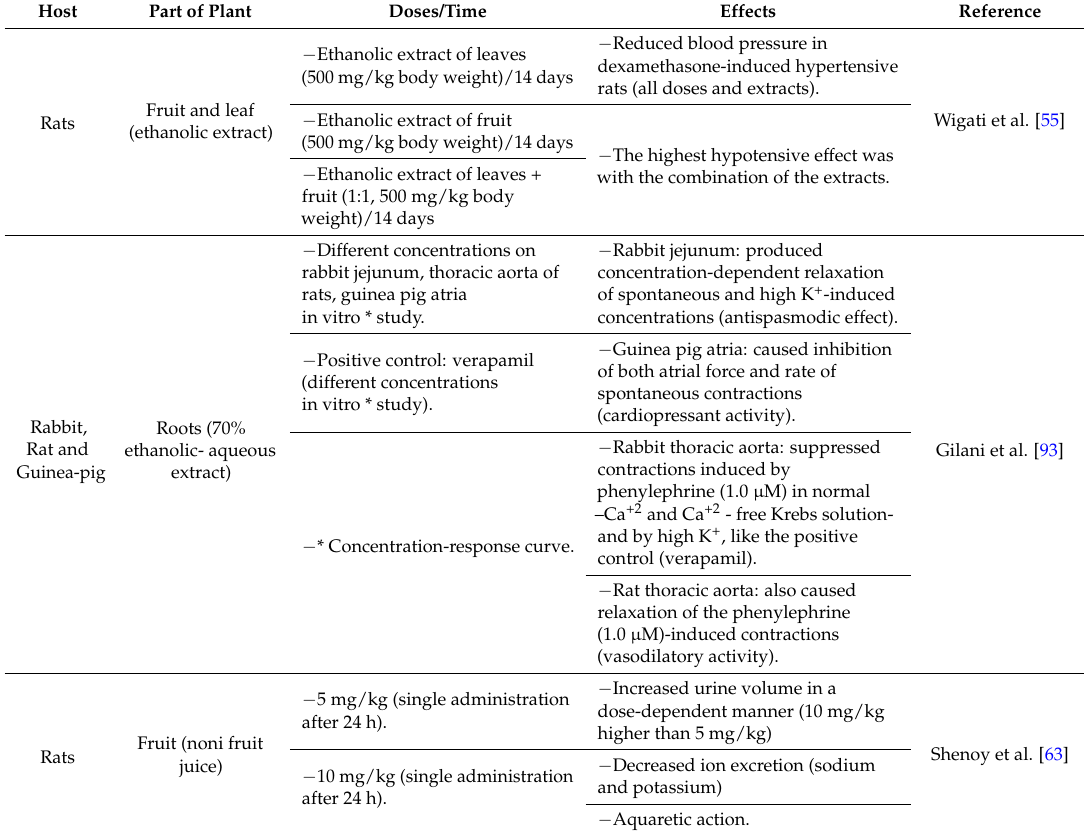
Table 6. The effects of the Morinda citrifolia plant on